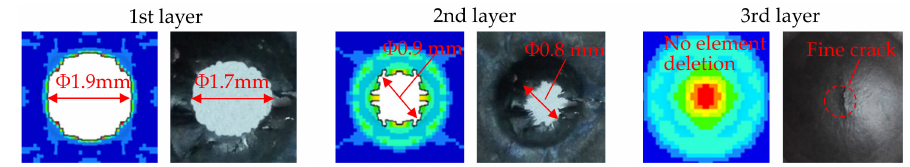
Figure 14. Comparison between experimental tests and simulation of fracture modes of anodes across different layers under local